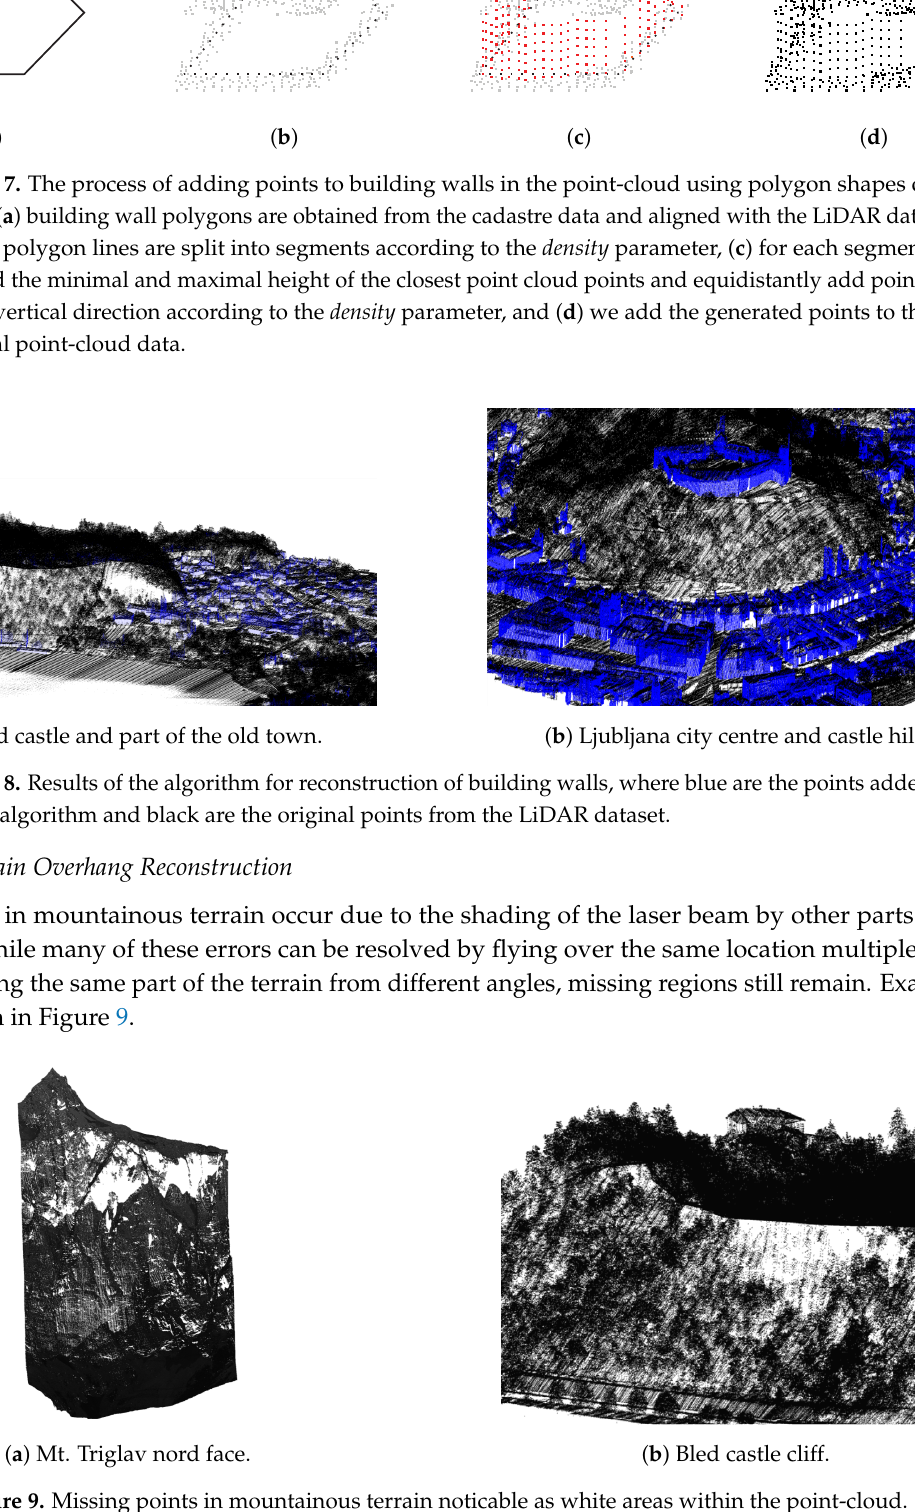
Figure 9. Missing points in mountainous terrain noticable as white areas within the